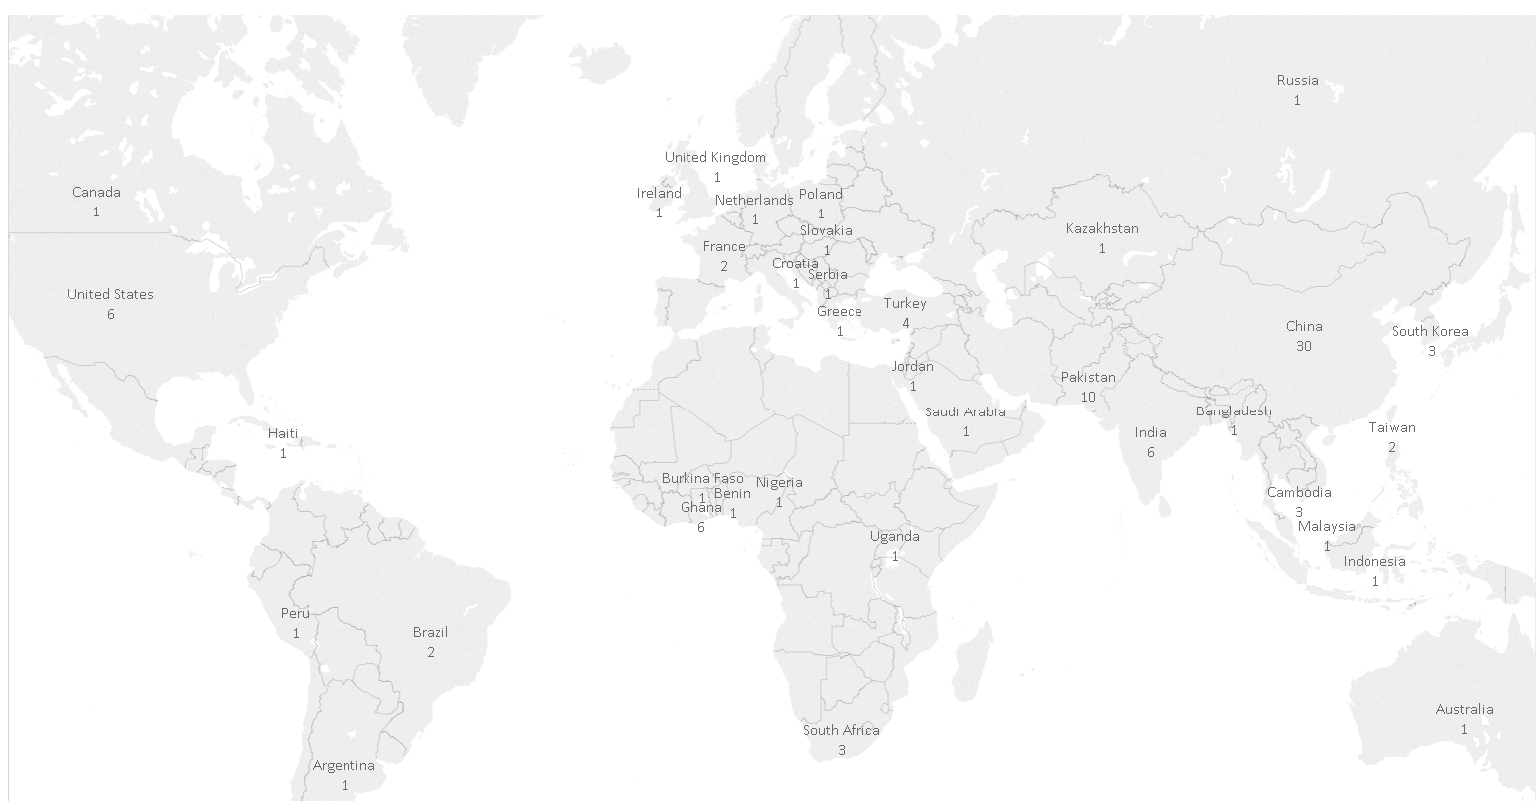
Figure 2. Number of scoping review studies by world region.